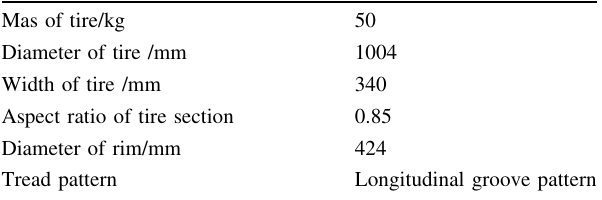
Table 2 Section geometry parameter of running tyre